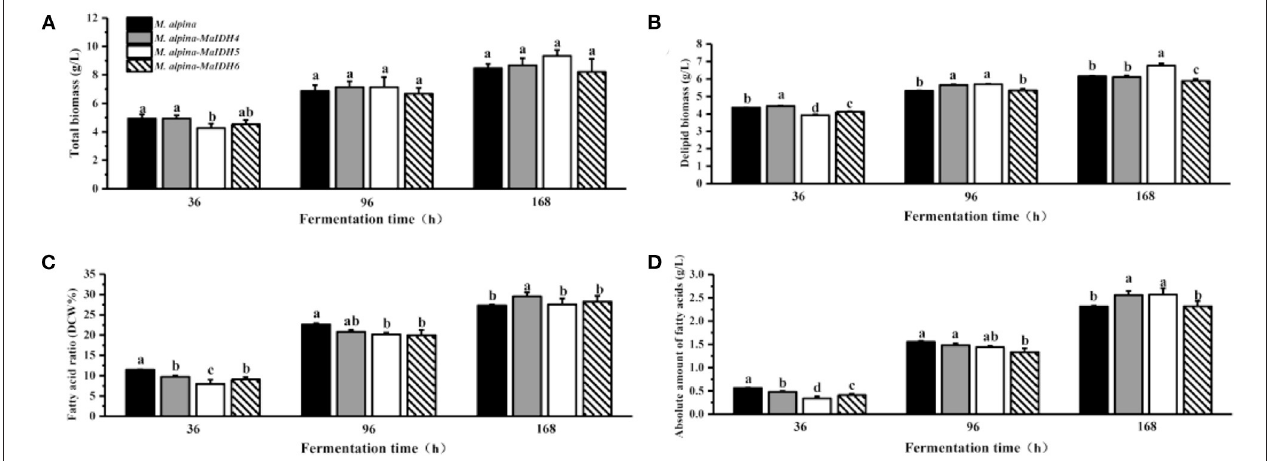
FIGURE 7 | Biomass and lipid accumulation of recombinant strains overexpressing NADP + -MaIDH at different time points (36, 96, and 168h). Different letters indicate significant differences, p < 0.05. (A) Total biomass, (B) delipid biomass, (C) fatty acid ratio, and (D) absolute amount of fatty